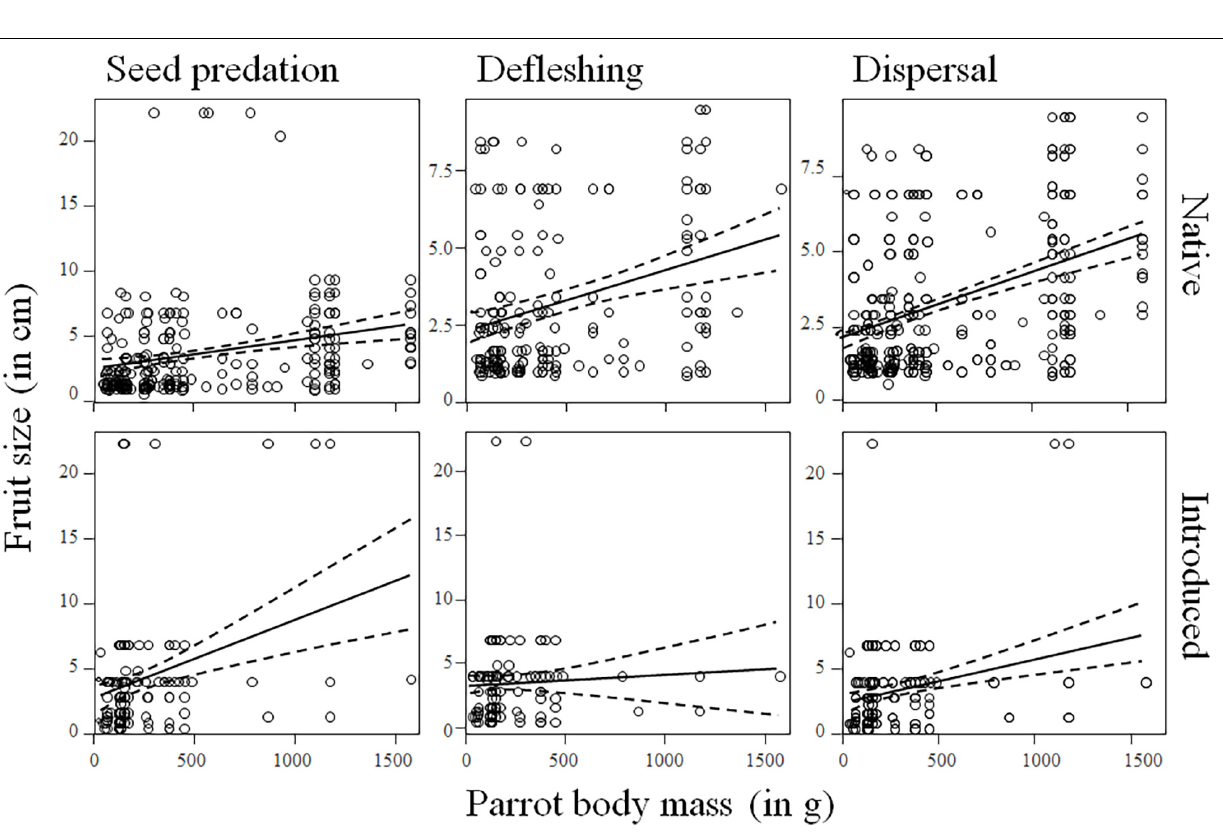
FIGURE 3 | Relationship between palm fruit size (measured as fruit length, in cm) and the size of the parrot (measured as body mass, in g) predating, defleshing, and dispersing them. See Supplementary Figures 2, 3 , and 4 for more detailed plots within each realm considered. The solid line represents the general trend across regions (dashed line: 95% confidence